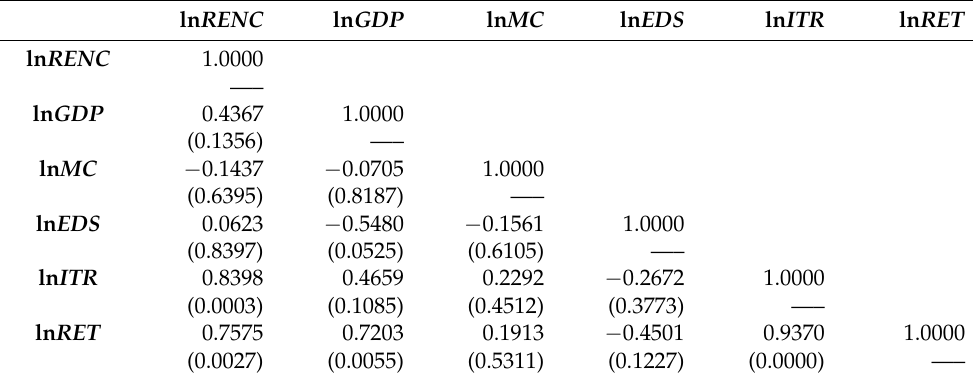
Table 4 includes the correlation coefficients. Table 4. Correlation